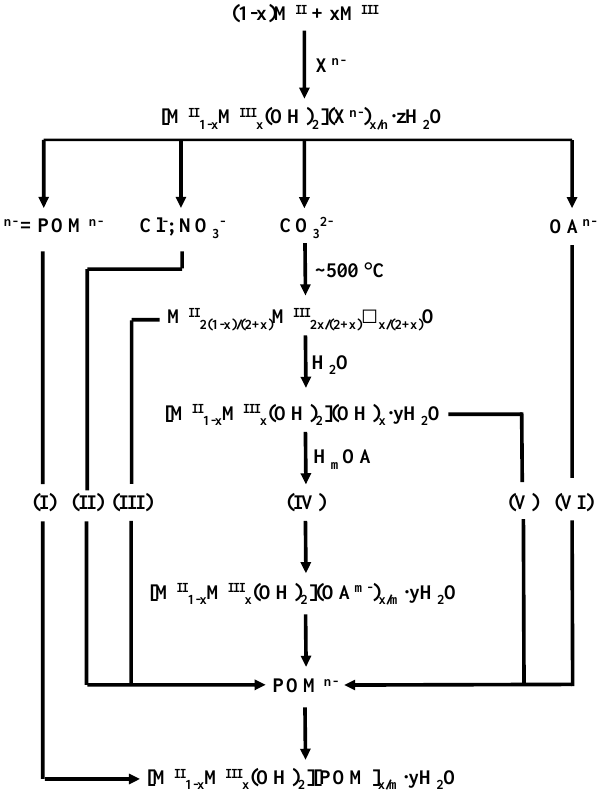
Figure 12. Representative methods used to prepare POW-LDH: (I) co-precipitation; (II) anion exchange; (III) anion exchange with calcined metal oxide; IV and VI, organic precursor methods, consisting in adding a preswelling agent; (V) anion exchange between an aqueous synthetic meixnerite and a POW solution. Adapted from Ref. [97], Copyright 1996, American Chemical Society.